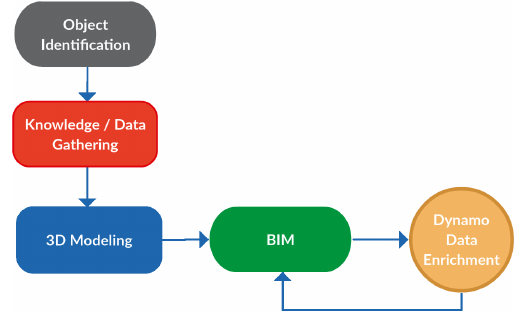
Figure 4. Visual Coding for Data Enrichment